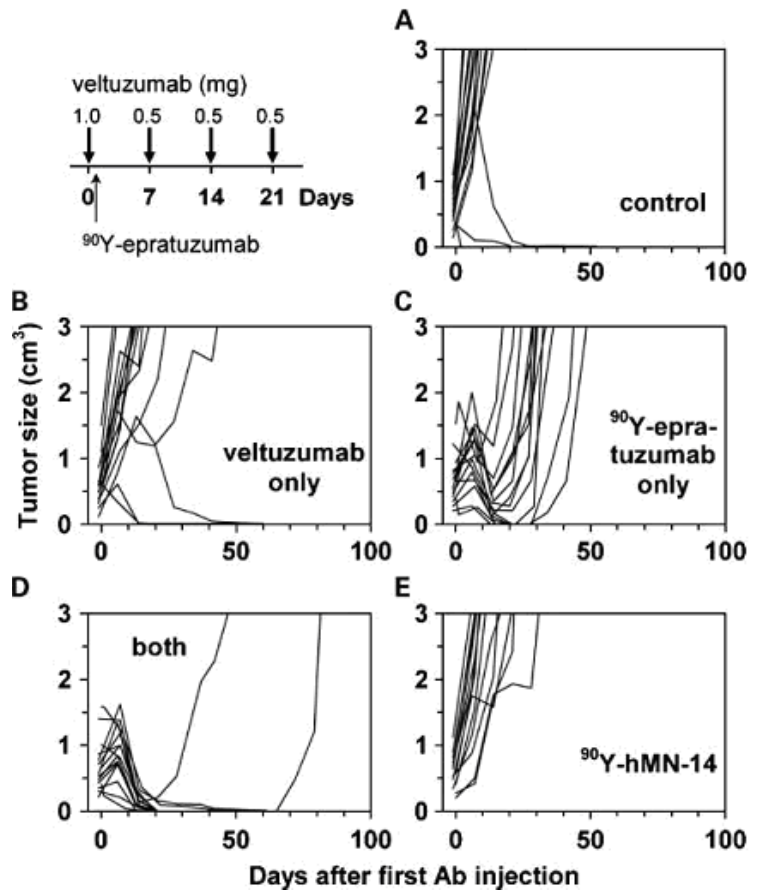
FIGURE 6. Therapy of s.c. Ramos tumors in nude mice (n = 13  15) with a combination of 90 Y-epratuzumab (0.175 mCi) and the indicated doses of unconjugated veltuzumab (hA20). Sequence of administrations is indicated top left. Panels are self-explanatory. Panel E shows treatment with nontargeting radioconjugate. Each panel shows the